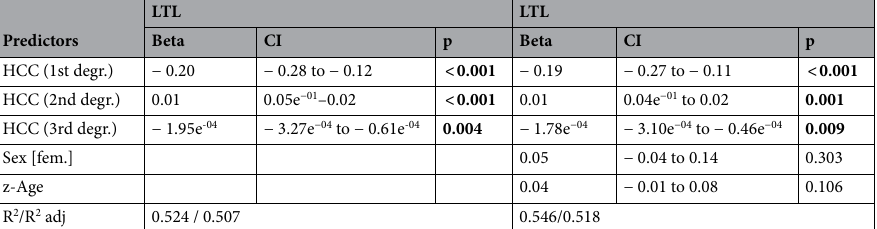
Table 3. Polynomial regression model predicting LTL by HCC (N = 89). Significant values are in bold. z-log natural logarithm and standardization, LTL leukocyte telomere length, HCC hair cortisol concentrations.